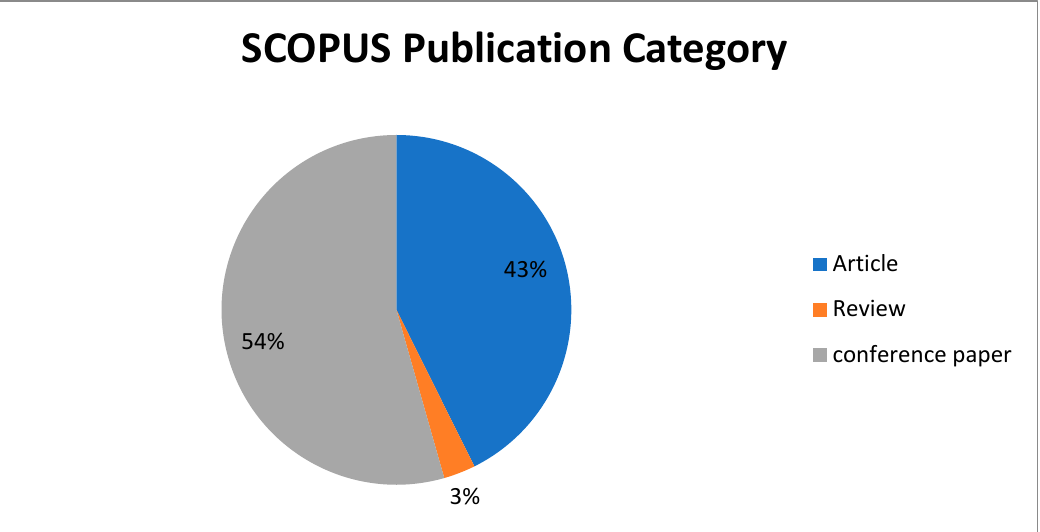
Figure 5. SCOPUS DB publication category in the field of BMS EV.